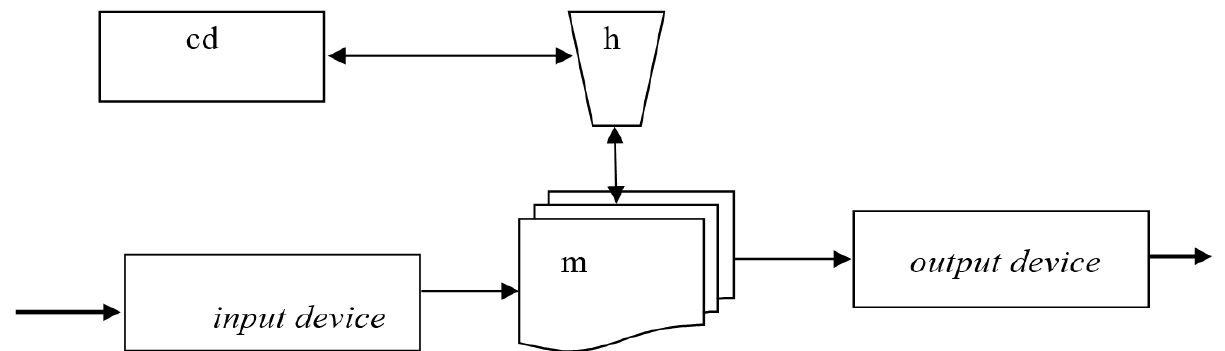
Figure 5. A schema of the transducer hardware.